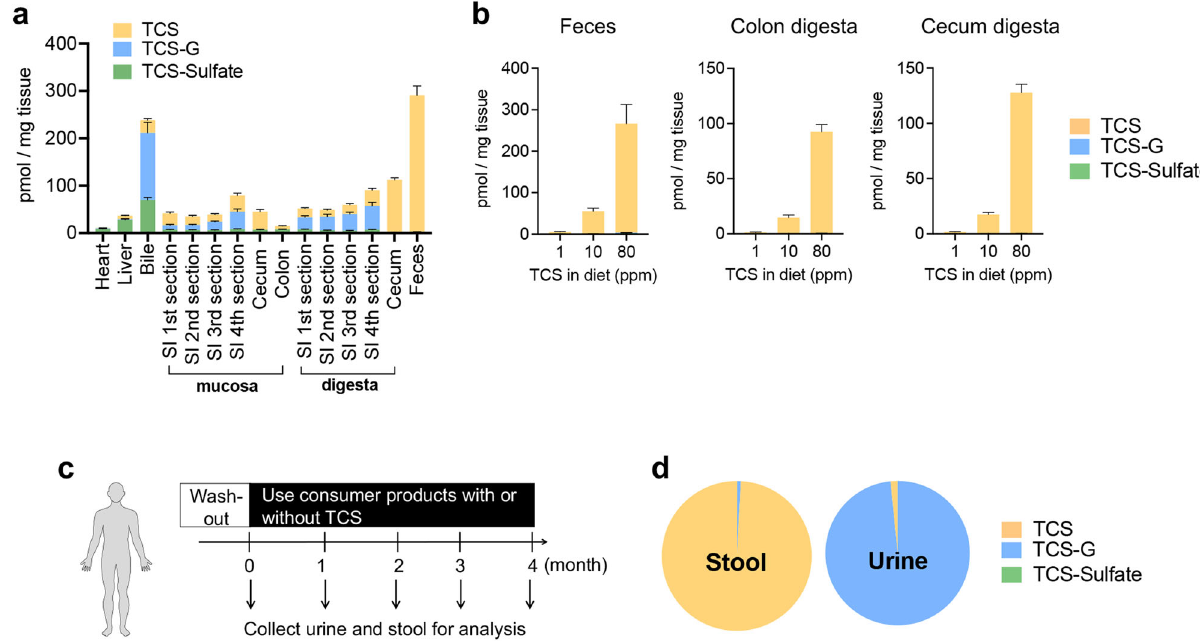
Fig. 1 TCS exposure in mice and humans leads to accumulation of free TCS in the colon. a After the mice were treated with 80 ppm TCS via diet for 4 weeks, cecum digesta and fecal contents exhibit high levels of free TCS while a mixture of TCS and metabolites is observed elsewhere ( n = 10 mice per group). b Mice were treated with 1, 10, and 80 ppm TCS via diet for 4 weeks. At all test doses, the gut tissues, including feces, colon digesta, and cecum digesta, exhibit high levels of free TCS and low levels of its metabolites ( n = 7 – 8 mice per group). c After a washout period, human subjects used personal care products, with or without TCS, for up to 4 months. Twenty-three fecal but only seven urine samples were collected. d The dominant compound in the stool samples of TCS-exposed human subjects was free TCS ( n = 23), while the dominant compound in the urine samples of TCS-exposed human subjects was TCS-G ( n = 7). See absolute concentrations of TCS and its metabolites in Supplementary Tables S1and 2. The data are mean ± SEM. Source data are provided with this paper. Abbreviations: TCS: triclosan, TCS-G: triclosan-glucuronide, TCS-sulfate: triclosan-sulfate. Part of the picture was adapted from